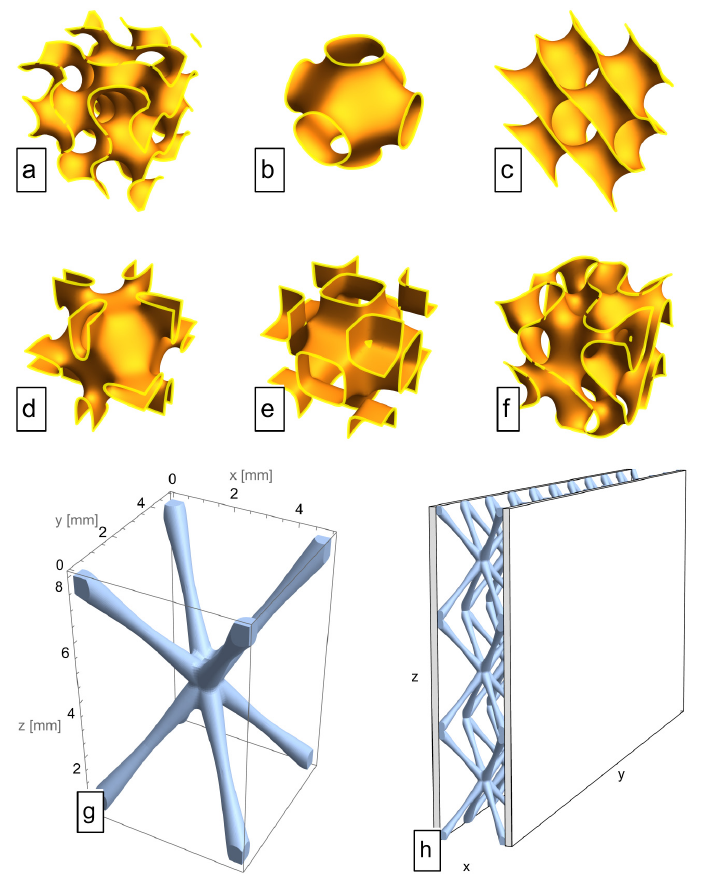
Figure 5. Investigated TPMS structures: Schwarz Gyroid ( a ), Primitive ( b ), Diamond ( c ), Nevious ( d ), Schoen I-WP ( e ), Fischer-Koch S Surface ( f ). Chosen lattice structure ( g ) and positioning within the wall ( h ). Table 4. Lattice cell geometry.